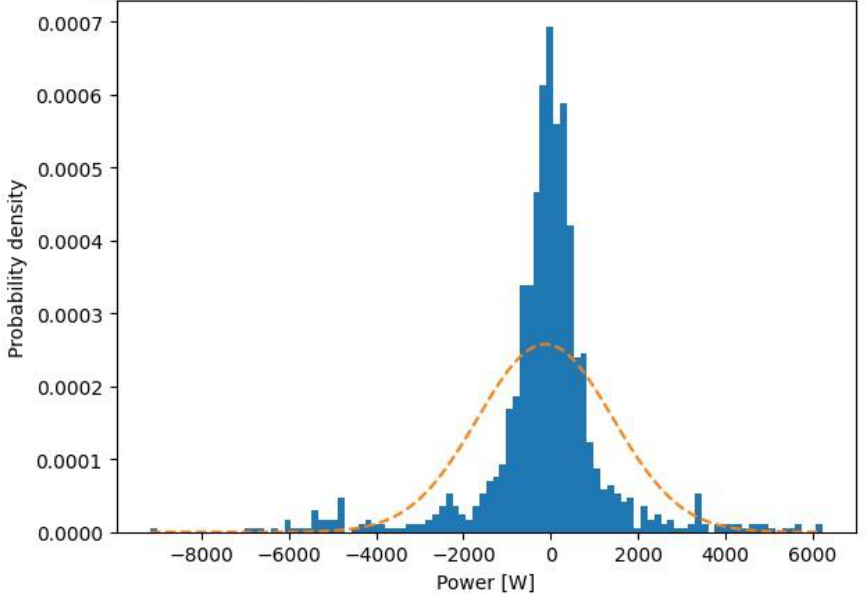
Figure 9. Histogram of residuals showing the probability density distribution of residuals resulting from the validation process of V-MLP-2.